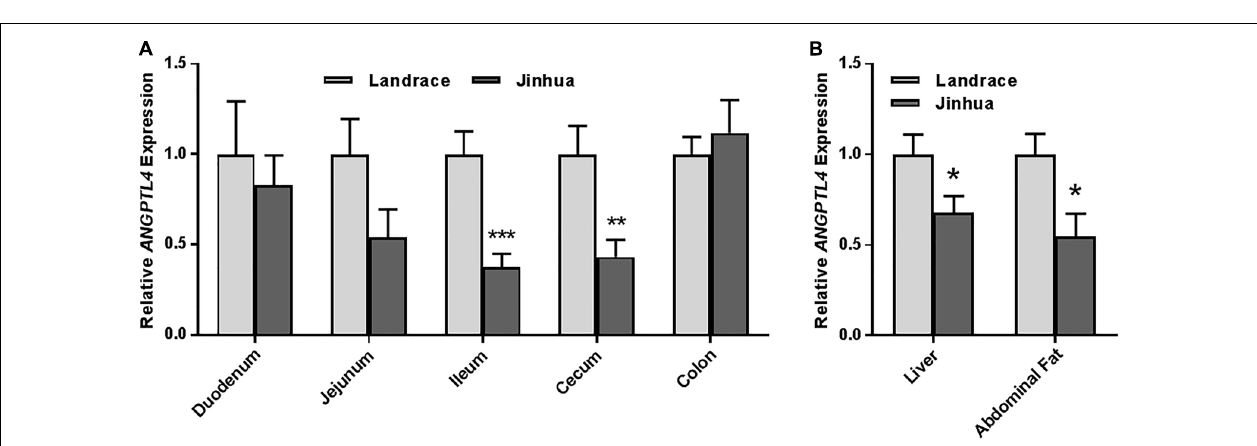
FIGURE 3 | Relative ANGPTL4 mRNA expression levels in the intestinal tract (A) and liver and abdominal fat (B) of Landrace and Jinhua pigs. The results were shown as means ± SEM of 10 pigs. ∗ P < 0.05, ∗∗ P < 0.01, and ∗∗∗ P < 0.001 (by unpaired Student’s t